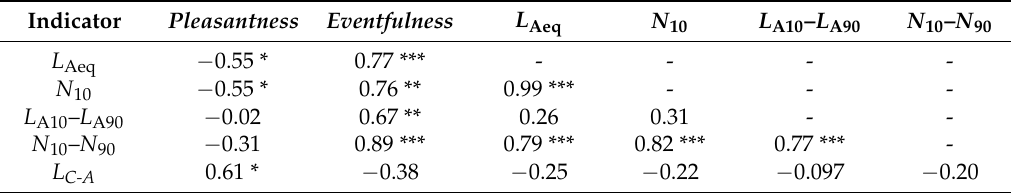
Table 4. Pearson’s coefficient of correlation amount soundscape indicators and descriptors for the 15 restaurant soundscapes in Experiment 2. For explanations, see text. * p ≤ 0.05, ** p ≤ 0.01, *** p ≤ 0.001.